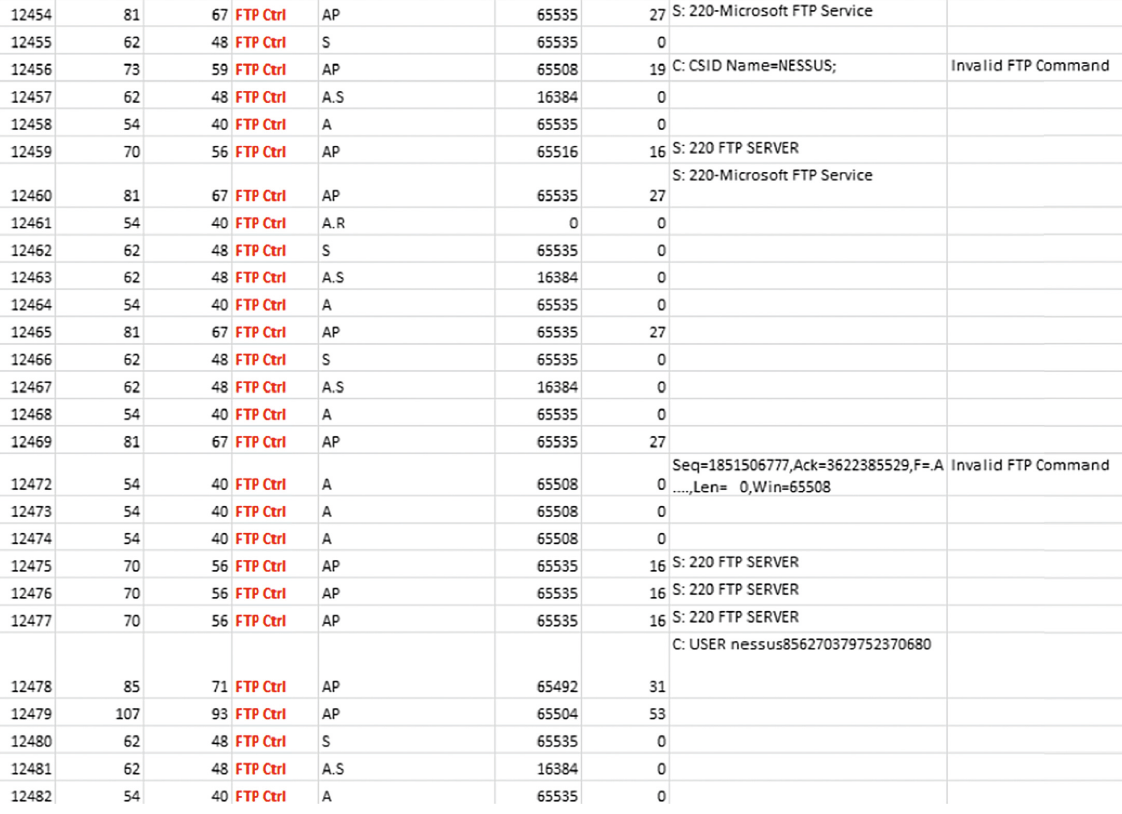
Figure 8: Features